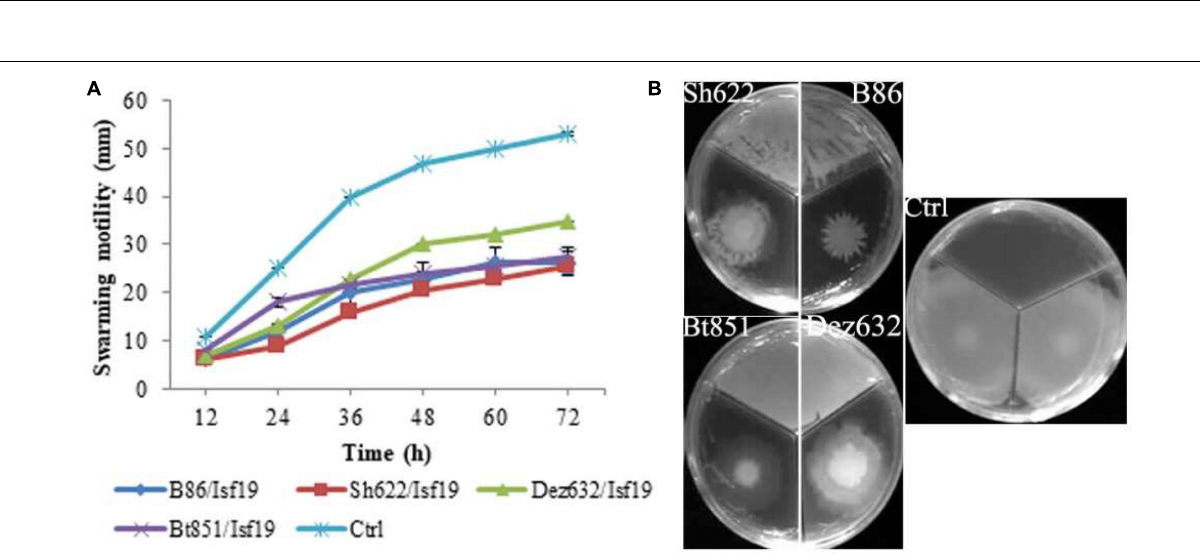
FIGURE 2 | Effects of VOCs produced by Streptomyces sp. B86 , Pantoea sp. Dez632 , Pseudomonas sp. Bt851, and Stenotrophomonas sp. Sh622 on swarming motility of B. pumilus Isf19 compared to the non-treated control (Ctrl). The diameter of motility zone (A) and representative plate of swarming motility assay (B) were shown. Three replicates were used for each treatment. Error bars indicate the SE of the three replicates. Different letters indicate significant differences ( P = 0.05).